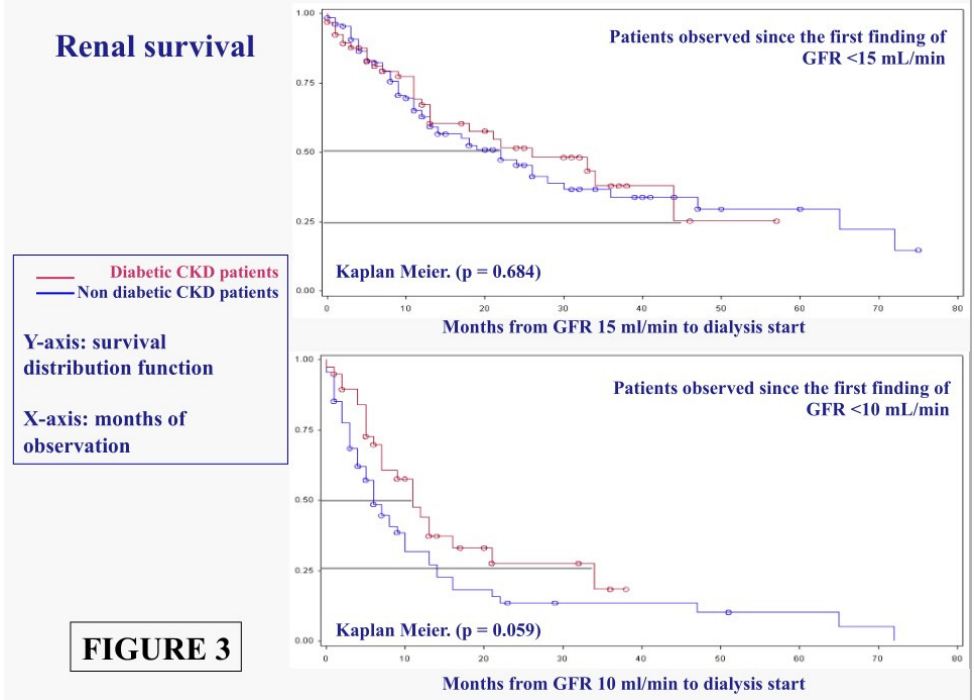
Figure 3. Time to start of the renal replacement therapy in diabetic and non ‐ diabetic CKD